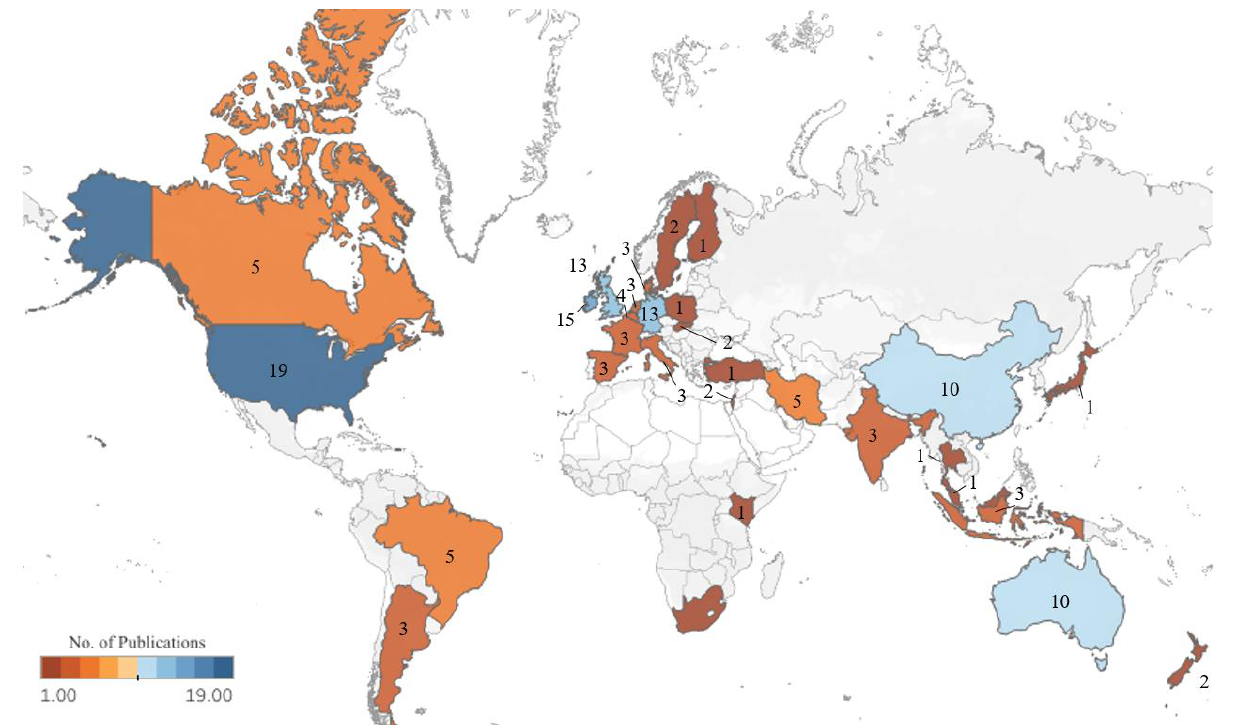
Figure 2. Geographical distribution of research studies (n = 139).